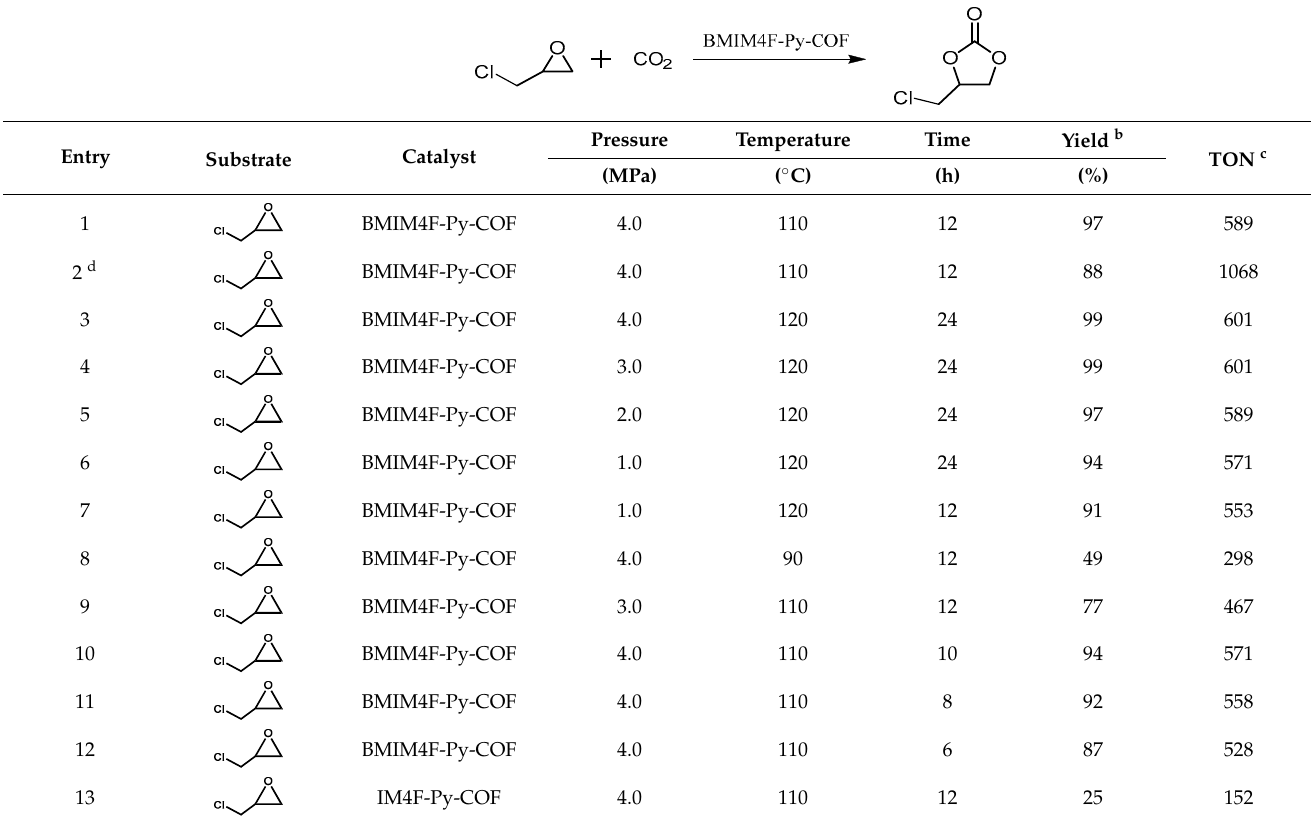
Table 1. Influence of various experimental conditions on cycloaddition reaction a .